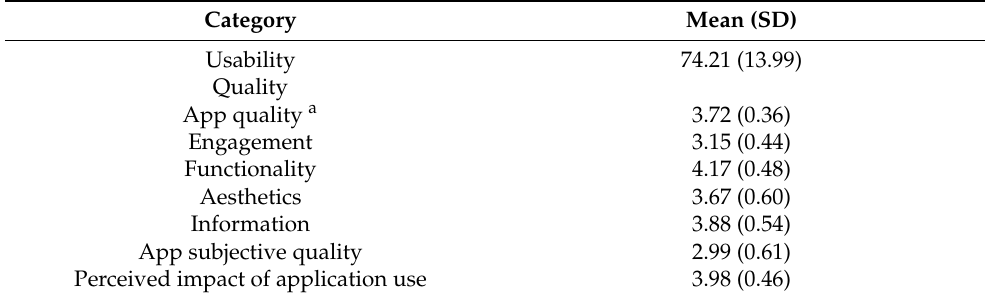
Table 1. Characteristics of participants (N = 35). Table 2. Perceived usability and quality of the developed